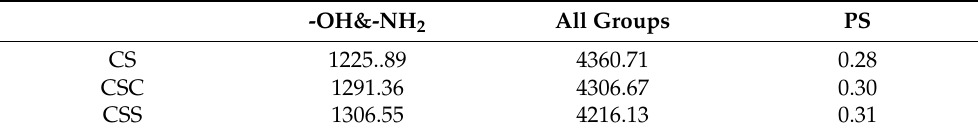
Table 4. Primary structure value of CS, CSC and CSS.